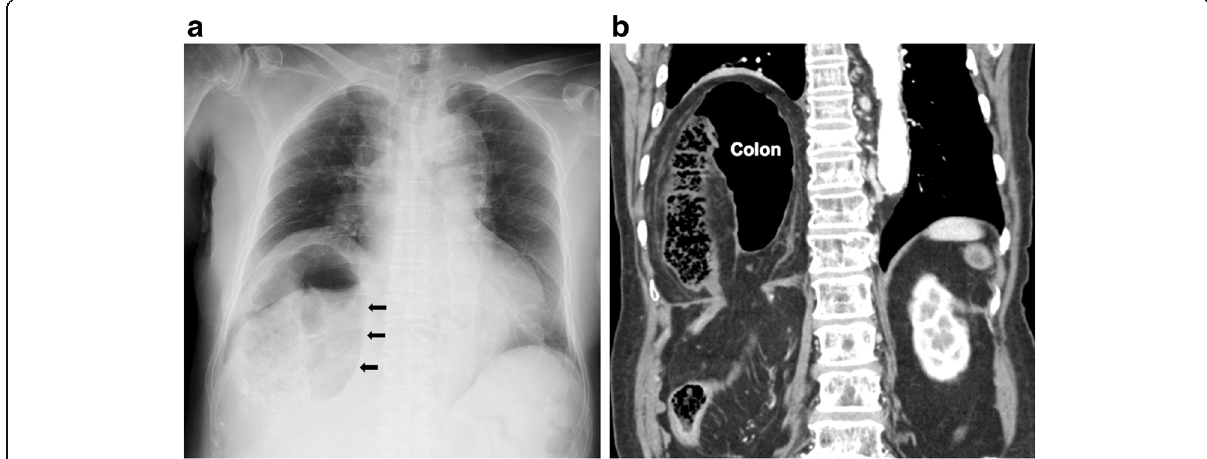
Fig. 5 Chest X-ray showing the dilated colon above the right diaphragm ( a ). CT scan showing strangulation of the colon with some ascites fluid in a sac ( b )